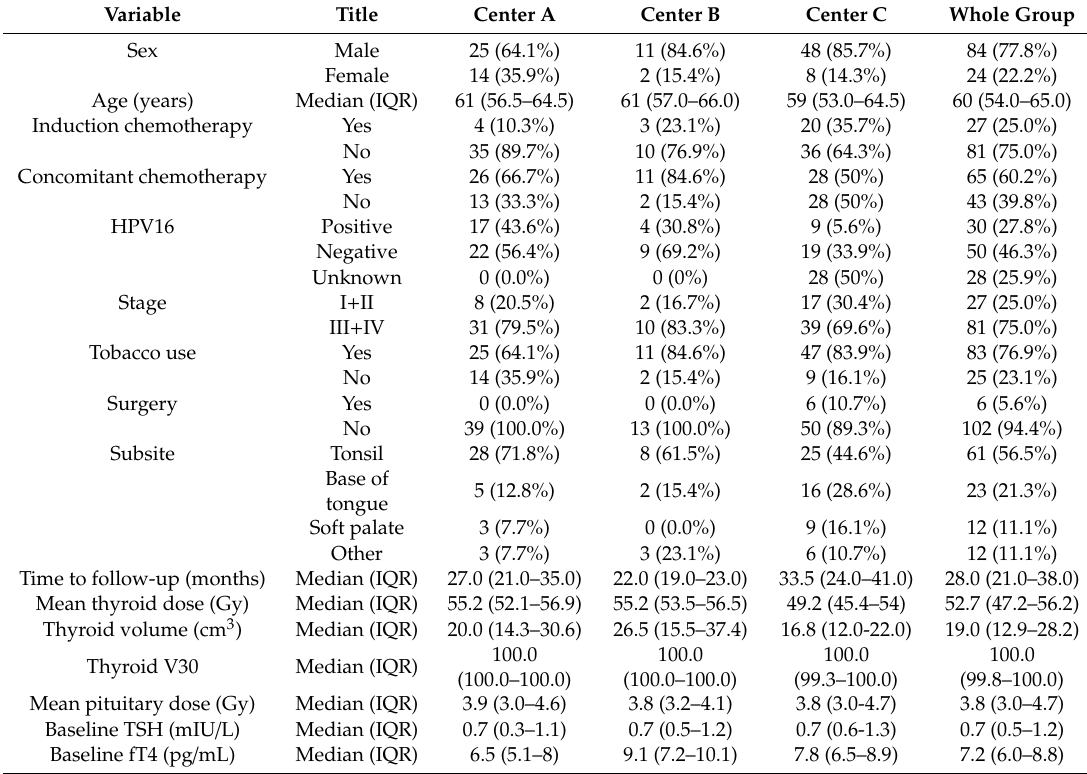
Table 1. Patient, disease and treatment